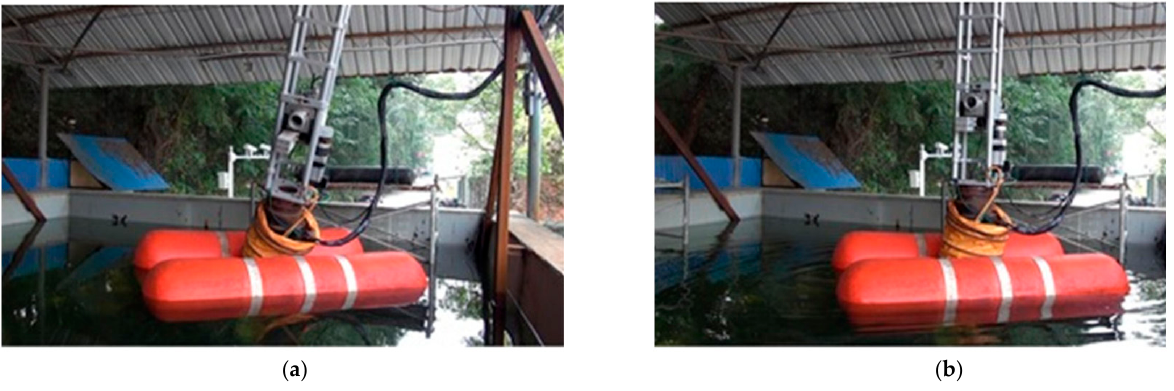
( b ) Figure 14. Drifting platform setup for the water surface stabilization experiment. ( a ) Empty water pool, ( b ) Full water pool. The experimental procedures are as follows: • Experiment one: Static experiment (1) After the pool is filled with water, the drifting platform floats 30 cm away from the bottom of the pool, without interference with the bottom of the pool during the move- ment. (2) The system is started, and the system levels itself at an equilibrium position for 10 min. •